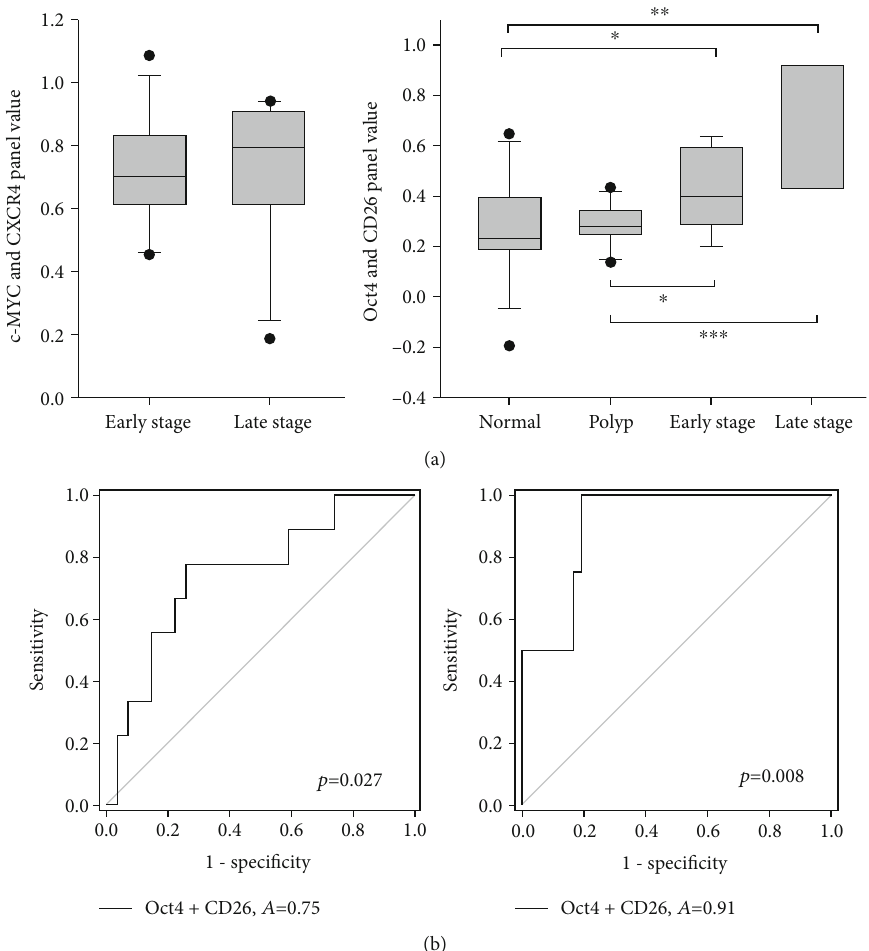
Figure 6: Identi fi cation of stage-dependent variation in gene panel values. (a) Comparison of the median value of normal, polyp, and early- stage and late-stage CRC patients in both Oct4 and CD26 panel and c-MYC and CXCR4 panel. (b) ROC analyses of Oct4 and CD26 panel for identi fi cation of early-stage CRC patients from normal and polyp patients (left) and late-stage CRC patients from normal, polyp, and early- stage CRC patients